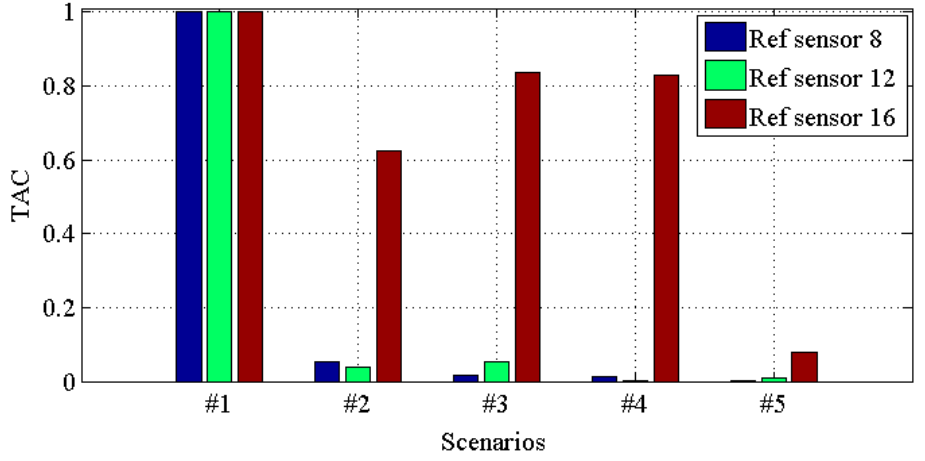
Figure 17. TAC for transmissibilities T(4, :), T(8, :), T(12, :) and T(16, :) with reference sensor 8, 12 and 16 for damage scenario #1 to #5.